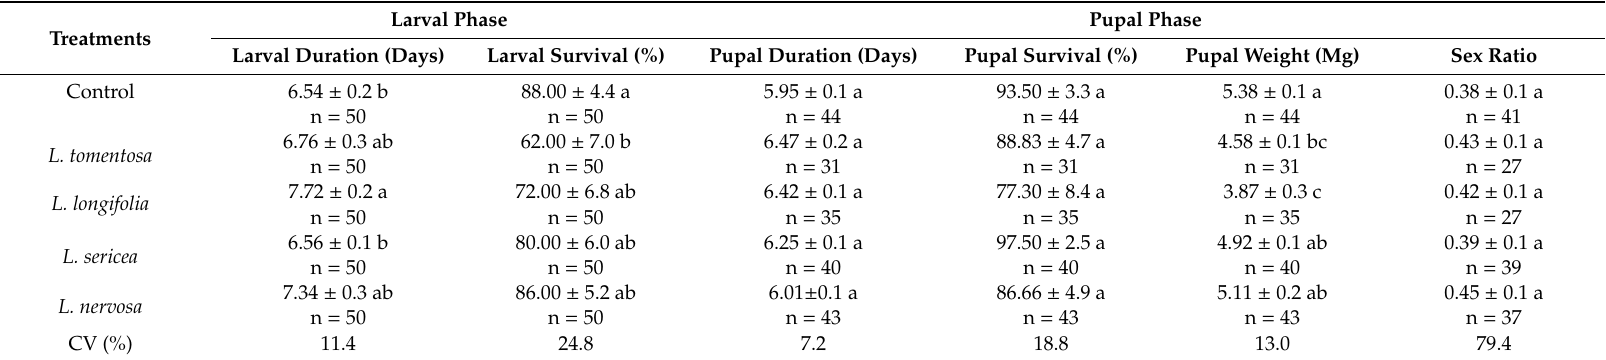
Table 1. Duration (days) of and survival (%) during larval and pupal stages, pupal weight (mg) and sex ratio of Plutella. xylostella L. treated with Ludwigia